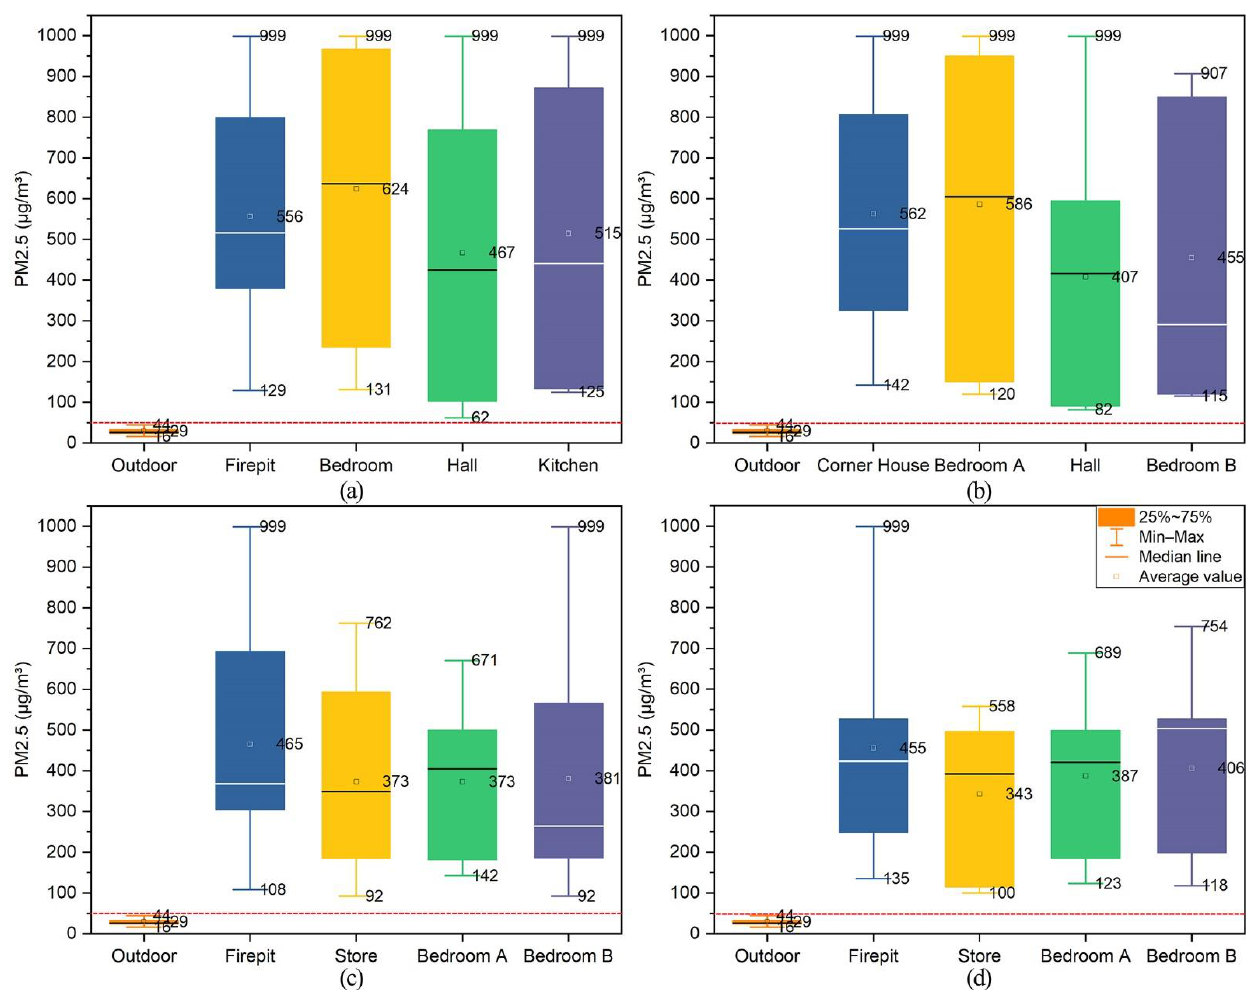
Figure 12. Analysis of PM 2.5 concentrations during indoor fires in ancient Tujia town dwellings. ( a ) Zuozi dwelling [34]. ( b ) L-shape dwelling [34], ( c ) lower store and upper house dwelling, ( d ) front store and back house dwelling.